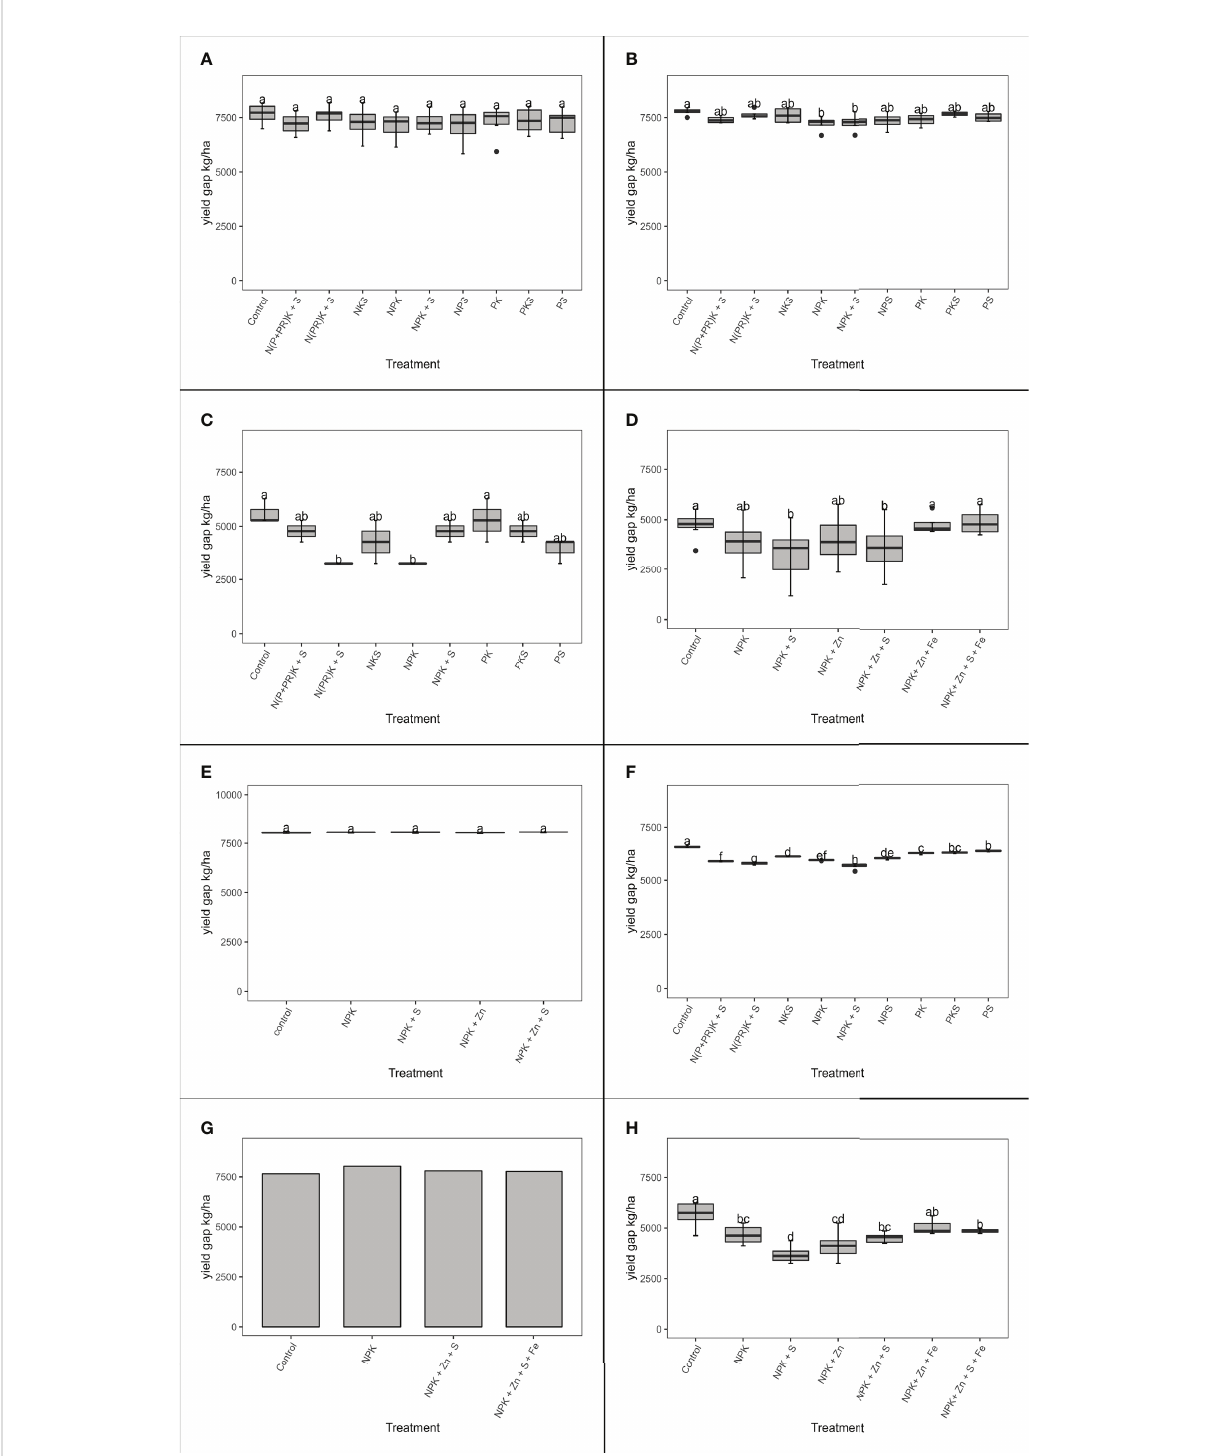
FIGURE 11 Statistical comparison of the yield gap recorded for each fertilizer treatment based on Duncan ’ s new multiple range test in the study sites: (A) Ashanti Anwomaso; (B) Ashanti Ayeduase; (C) Ejura; (D) KNUST; (E) Mampong; (F) Nyankpala; (G) Sunyani; and (H) Wenchi. The small letters are the signi fi cance of the statistical differences of the treatments. The only meaning is to show which treatment are signi fi cantly different and the ones that are not signi fi cantly different. The letters were automatically generated by the statistical